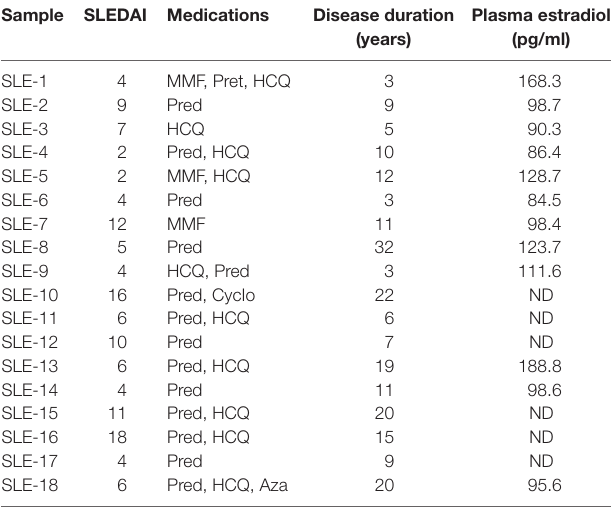
TaBle 1 | Systemic lupus erythematous (SLE) patient data. sample sleDai